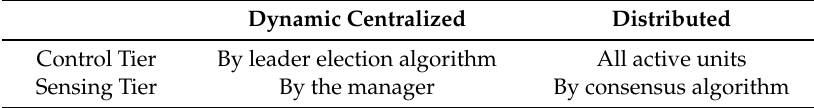
Table 1. Role selection and activation mechanisms for the different role